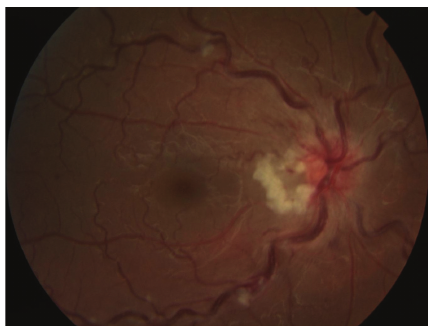
Figure 1: This is a picture of the fundus of the right eye showing dilatation of the veins, cotton wool spots (along the vessels), and exudates (adjacent to the optic